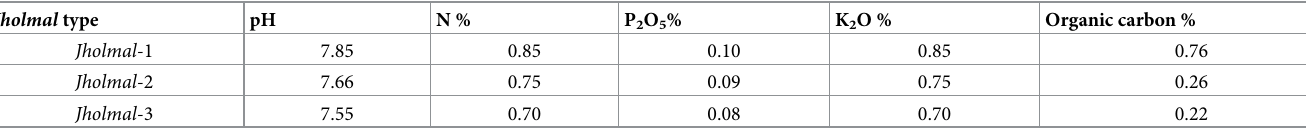
Table 4. pH and nutrient content in different types of jholmal .